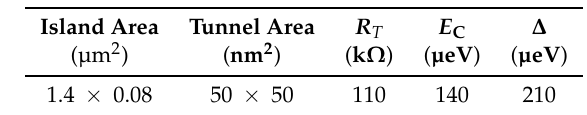
Table 1. Typical measured values for the NISIN transistor parameters. Values of R T , E C and ∆ are measured at T ≈ 15